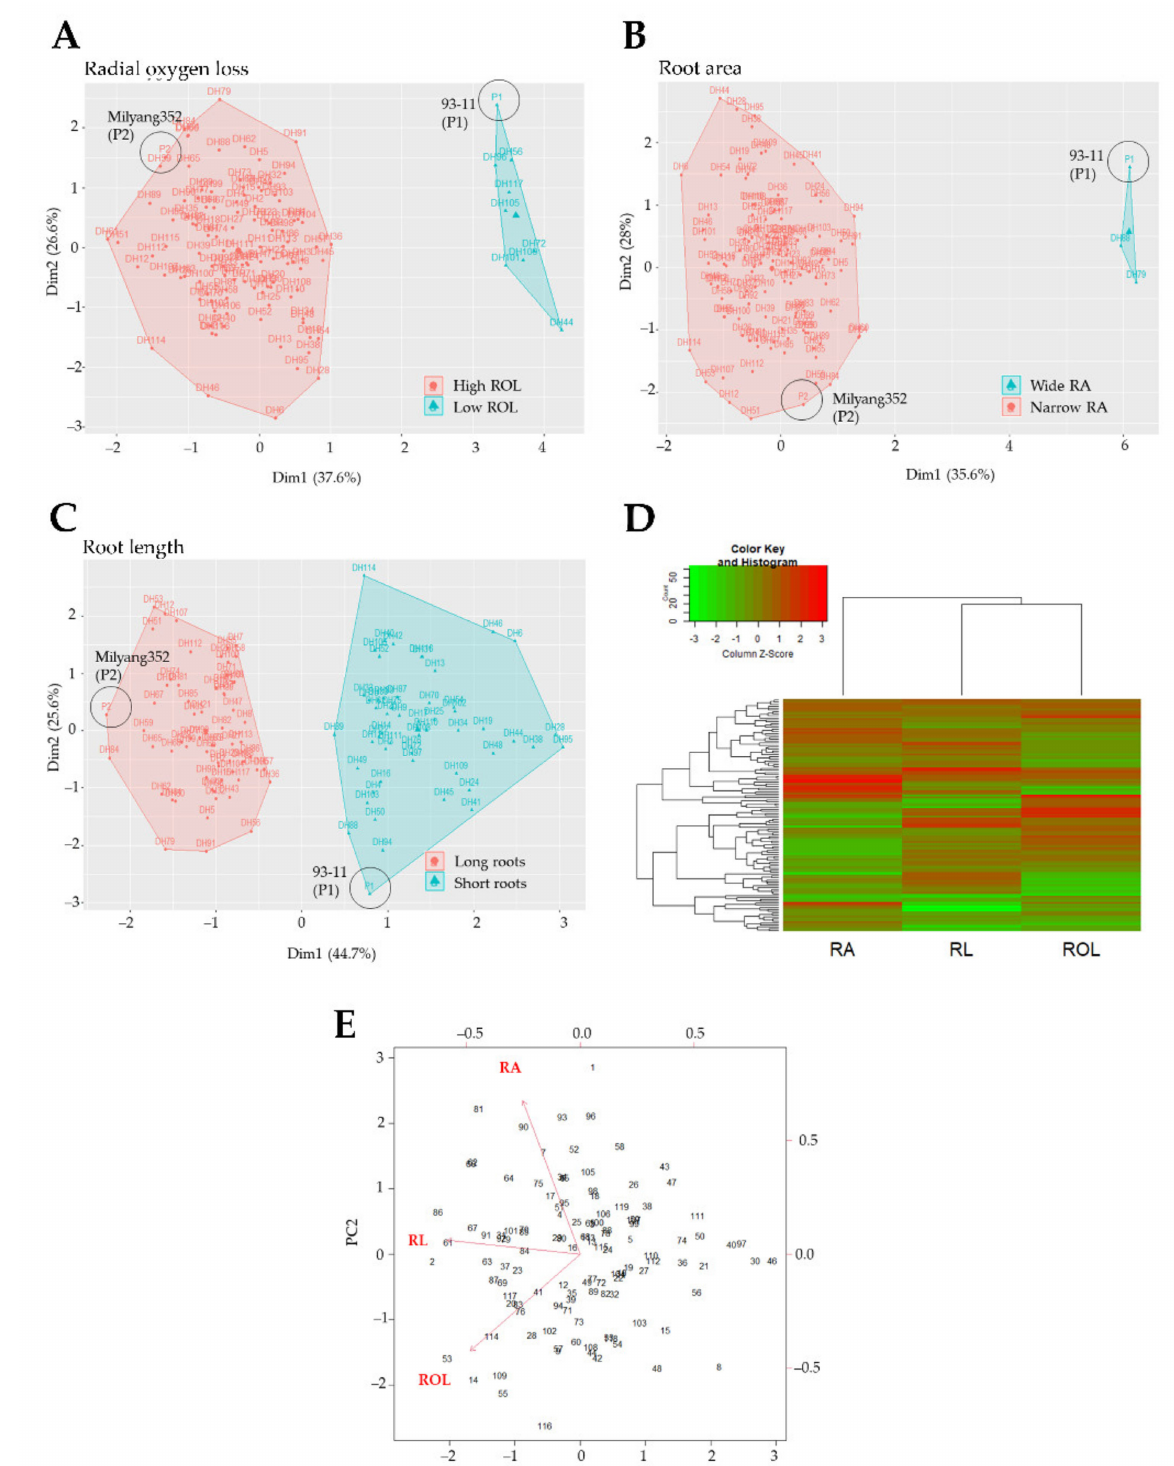
Figure 3. Principal component analysis results. Cluster plots displaying the distinctive phenotypes of parental lines (93-11, P1 and Milyang352, P2) and the grouping of the mapping population based on radial oxygen loss (ROL) rate ( A ), ( B ) root area (RA), and ( C ) root length (RL). ( D ) Heat map with dendrograms indicating the affinity between traits in response to FeS treatment, ( E ) PCA indicating the correlation between the analyzed traits on the mapping